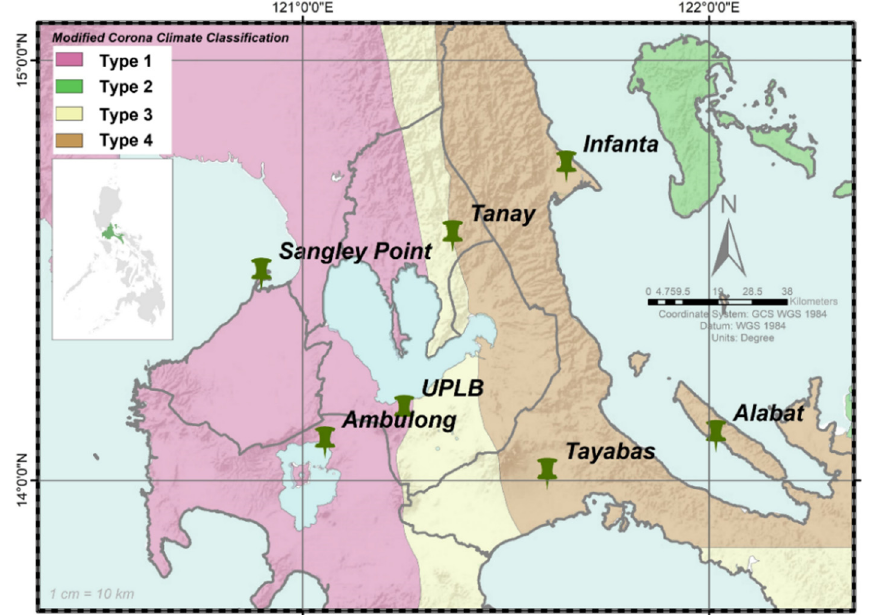
Figure 1. DOST-PAGASA weather stations considered in this study.